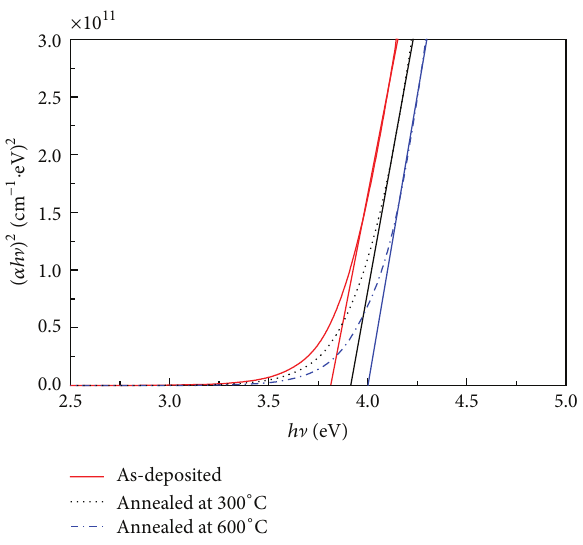
Figure 7: Variation of (𝛼ℎ ] ) 2 with ℎ ] for ITO thin films.